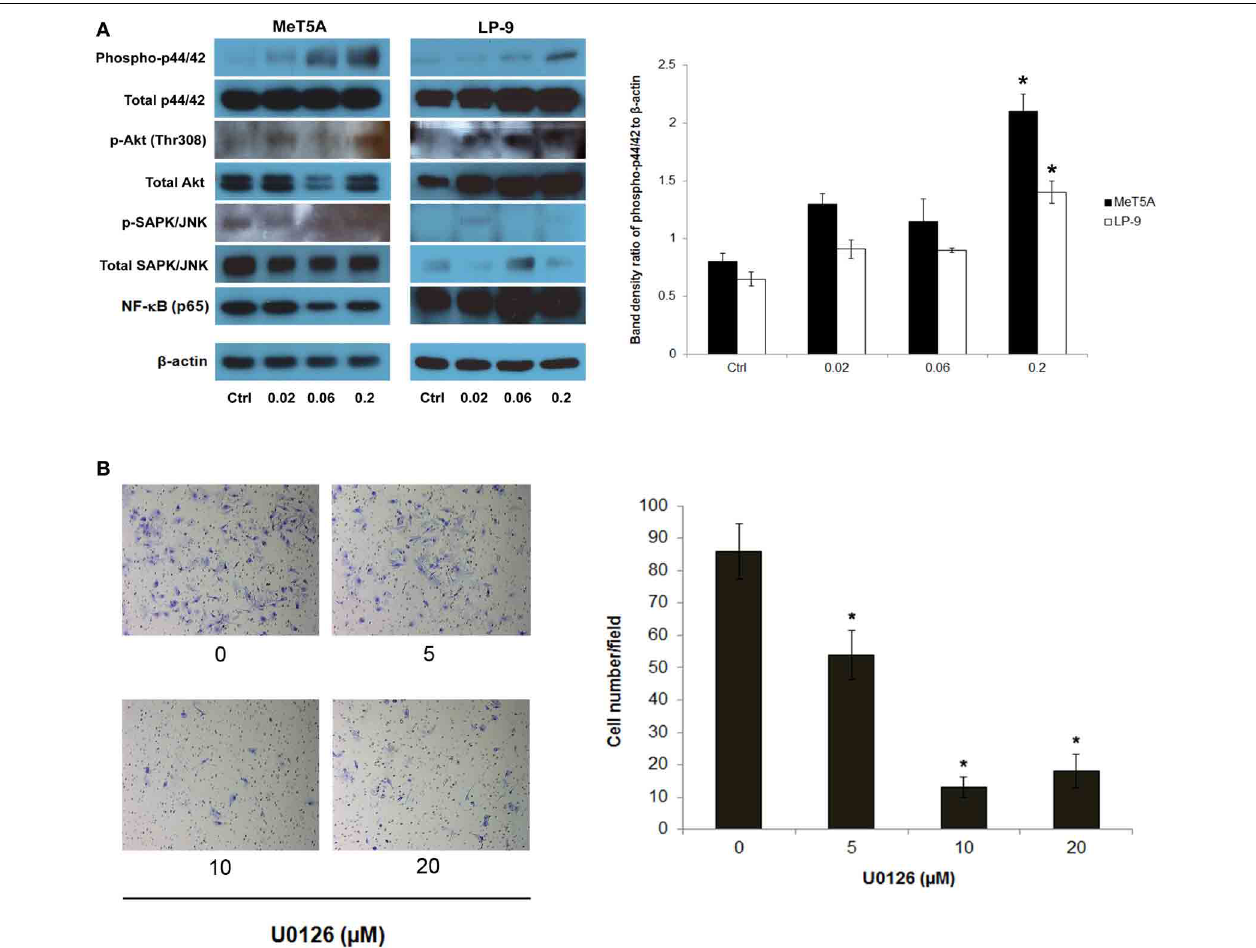
FIGURE 3 | Analysis of downstream effectors of H-Ras in SWCNT-exposed MeT-5A and LP-9 cells. A dose-dependent activation of p44/42 (ERK1/2) was evident in the SWCNT-exposed cells (A) . U0126, an ERK kinase inhibitor, was used to confirm the importance of ERK activation in the invasiveness of SWCNT-exposed cells. SWCNT (0.2 μ g/cm 2 )-exposed Met-5A